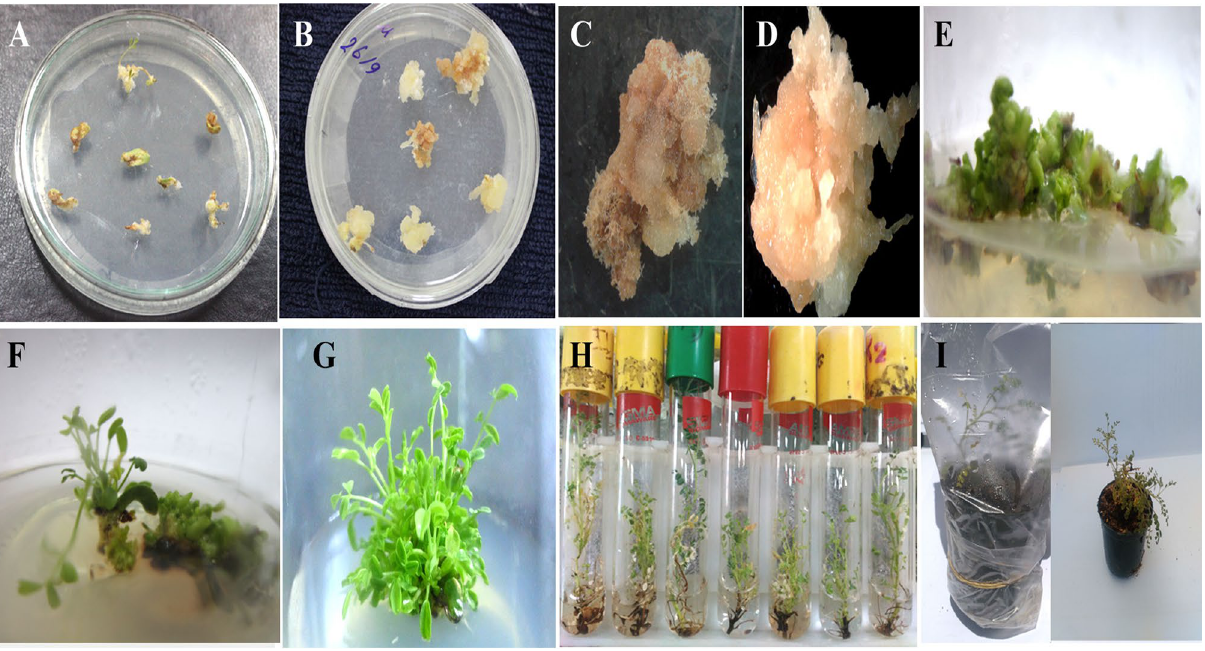
Figure 1. The regeneration stages of transformed A. trigonus plants. ( A ) The start explant; ( B ) Transformed calli on MS medium with bialaphos; ( C ) non-transformed callus on selective MS medium; ( D )